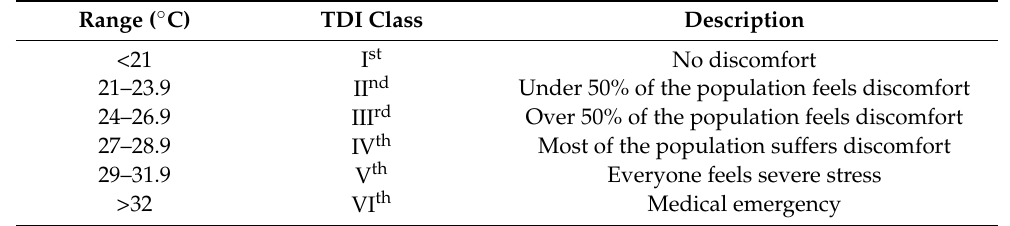
Table 1. Thom’s discomfort